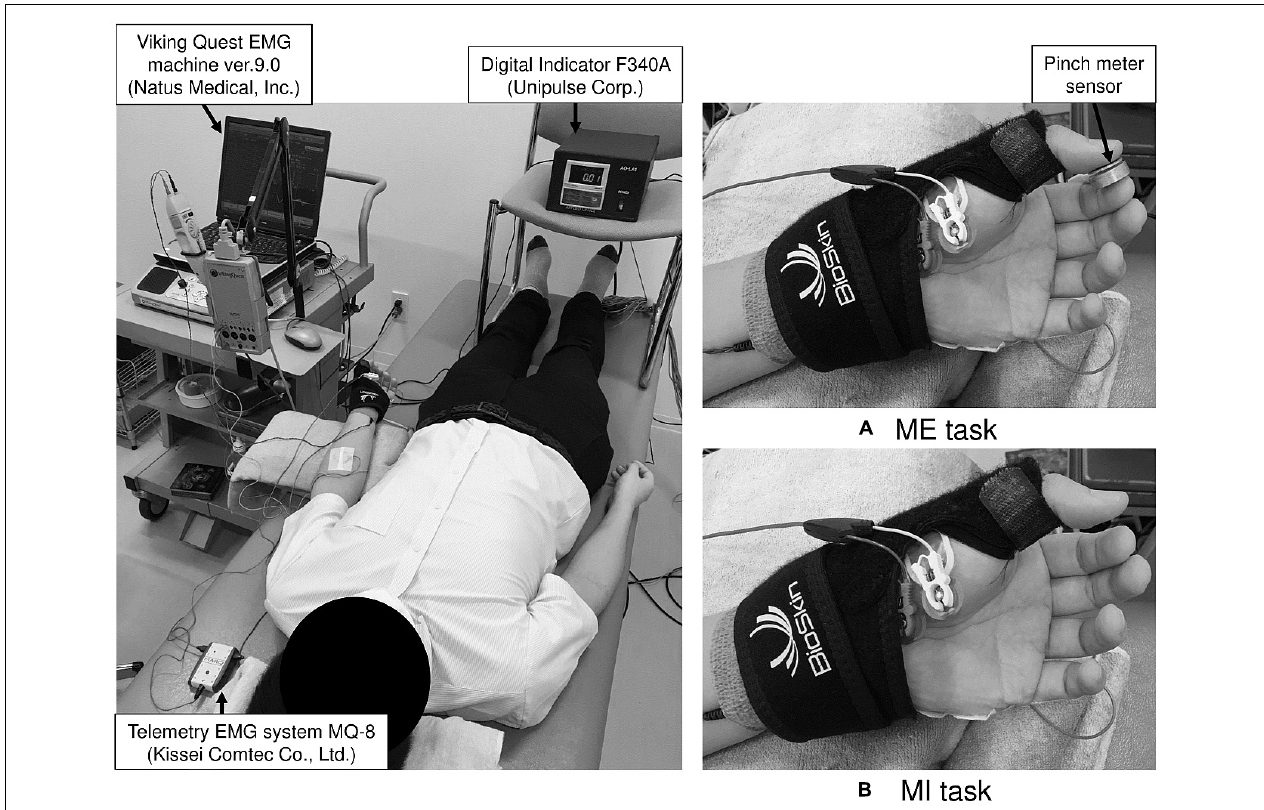
FIGURE 1 | The experimental setup for the motor execution (ME) and motor imagery (MI) task. During examination, the left thumb and index finger were fixed in opposition position using a splint to maintain the same position in the ME (A) and MI (B)